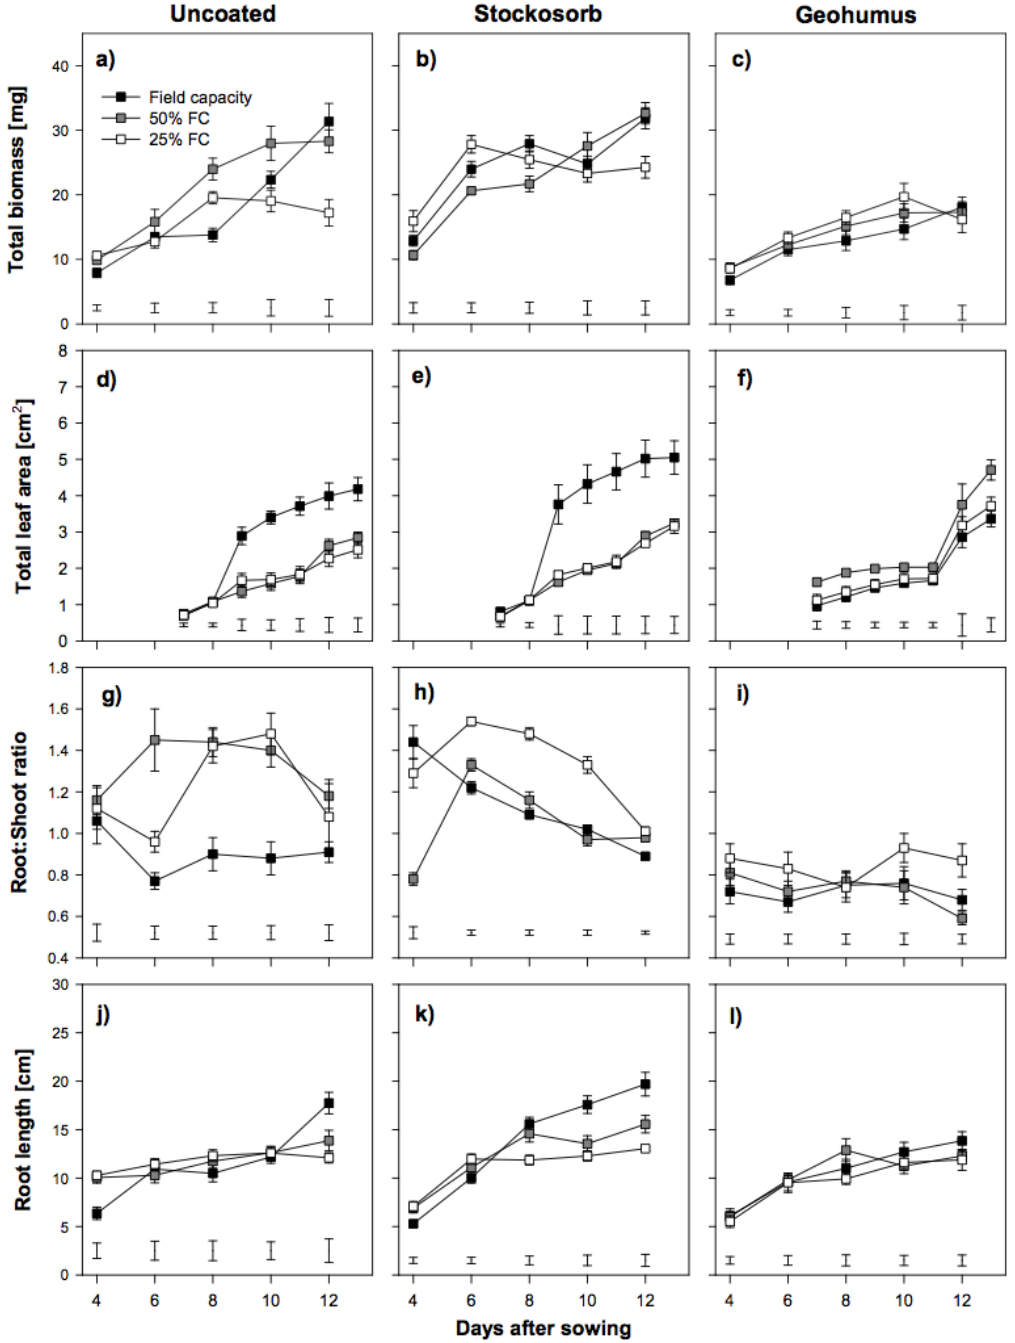
Figure 3. Effects of drought stress on total biomass, leaf area, root:shoot ratio and root length of Susu seedlings uncoated (a, d, g, j) coated with two hydro-absorbers, Stockosorb (b, e, h, k) and Geohumus (c, f, i, l). (Bars on data points denote standard error while those in graphs indicate the least significant difference at alpha = 5% and FC = field capacity).